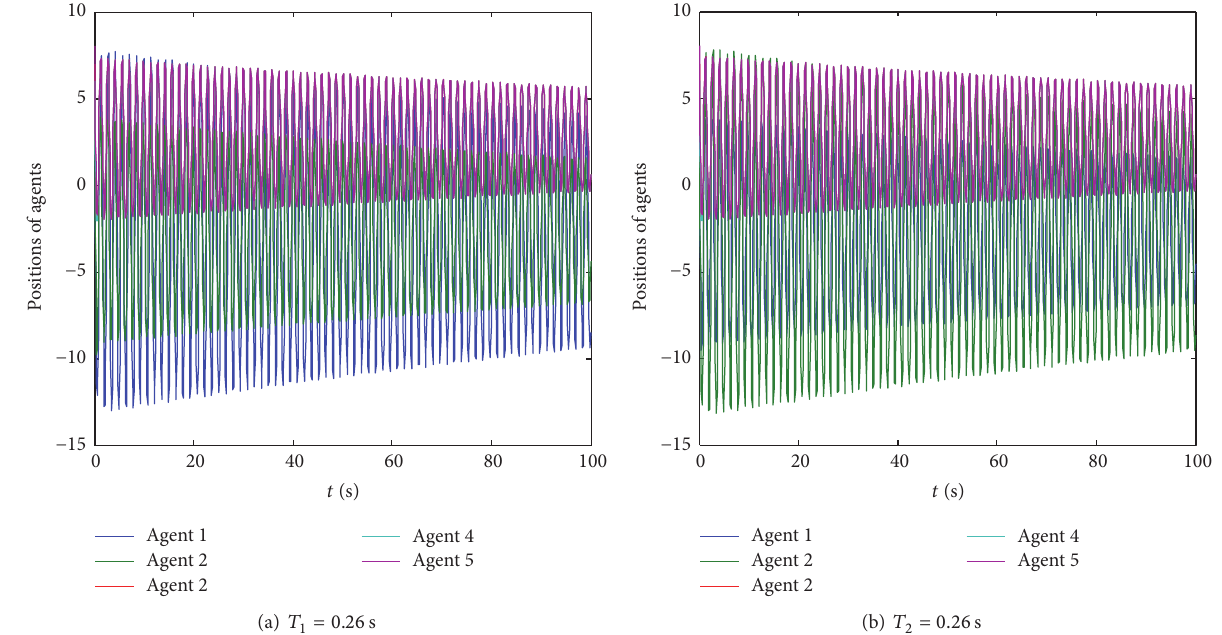
Figure 3: State trajectories of the agents in the networks (5) with diverse input delays when 𝑇 𝑖𝑗 = 0.1 s.